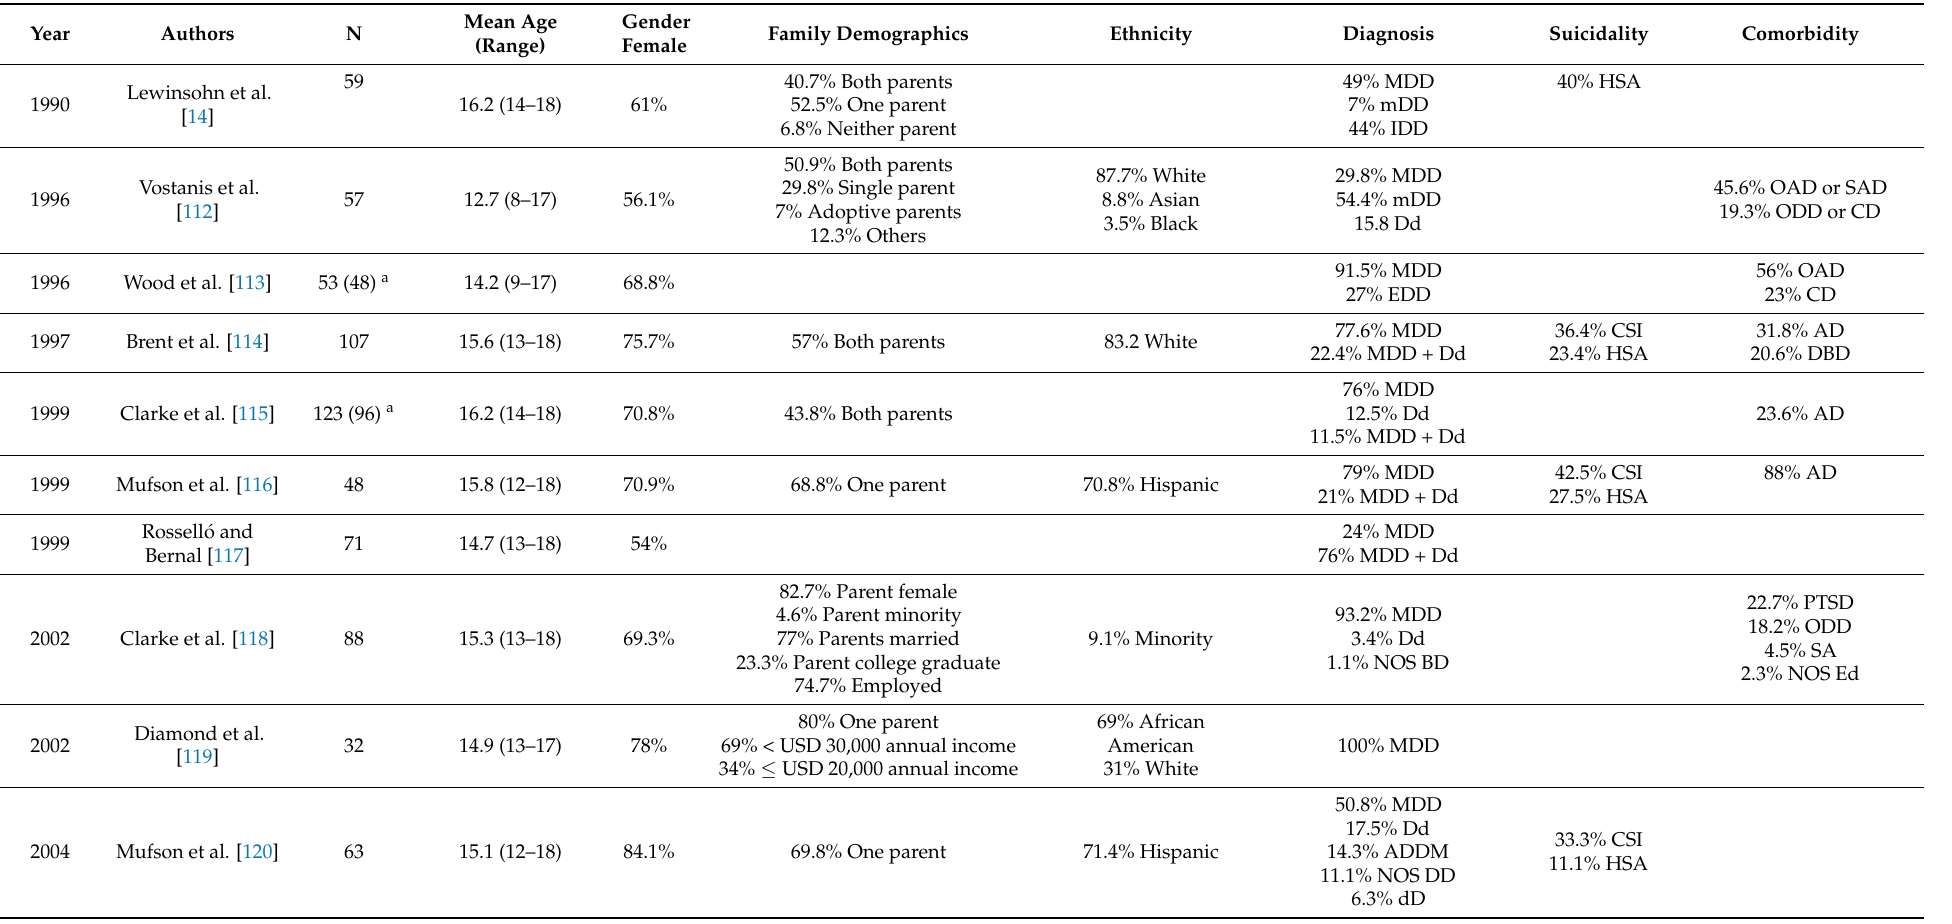
Table 3. Sociodemographic and clinical characteristics of the participants in trials included in the current